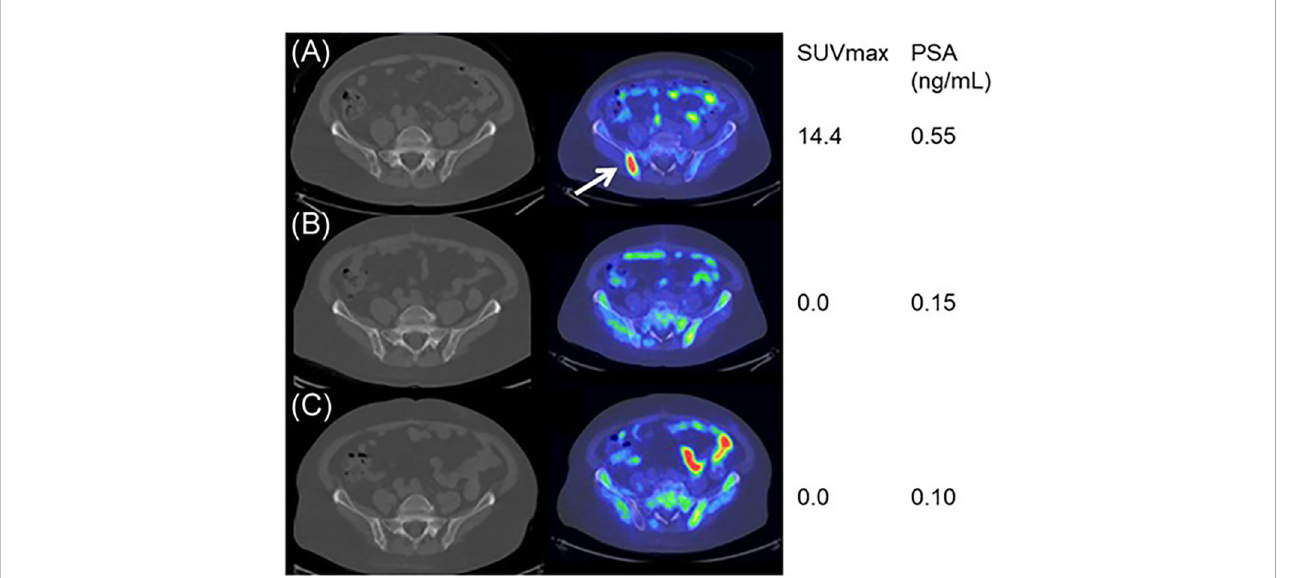
FIGURE 2 11 C ‐ choline PET/CT imaging during the docetaxel chemotherapy for a good responder. Baseline (A) , mid ‐ course (B) , and posttherapy (C) axial fused 11 C ‐ choline PET/CT images demonstrating markedly choline ‐ avid right posterior iliac bone metastasis at baseline (arrow), while nearly none at mid-course and posttherapy. Reprinted with permission from Jimbo et al. (54). Copyright © 2021 Wiley Periodicals